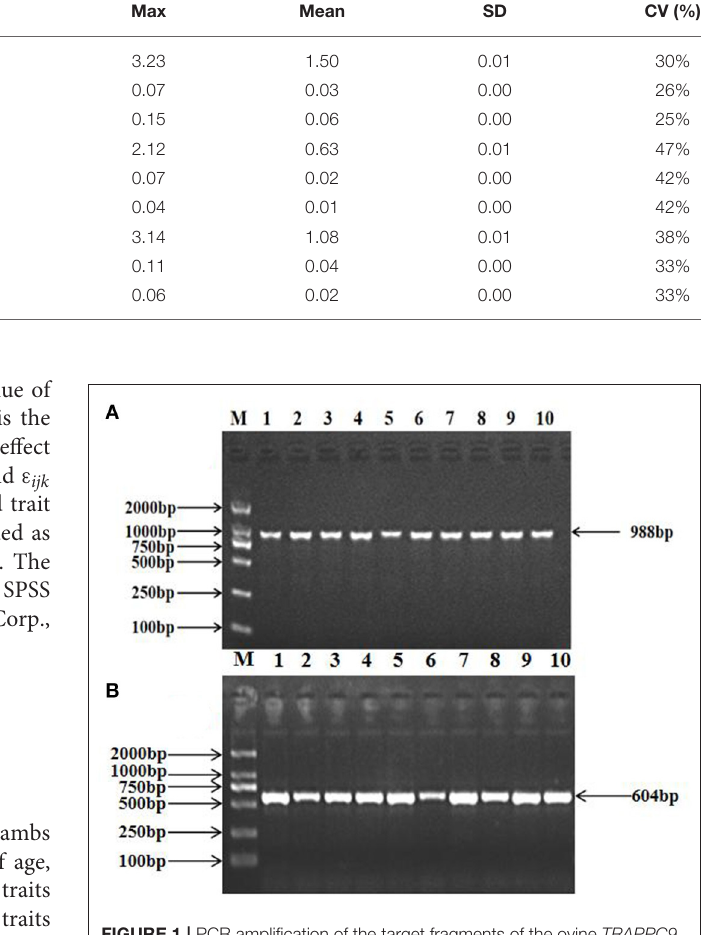
FIGURE 1 | PCR amplification of the target fragments of the ovine TRAPPC9 (A) and BAIAP2 (B) genes. M: DL2000 DNA Marker; 1–10: PCR